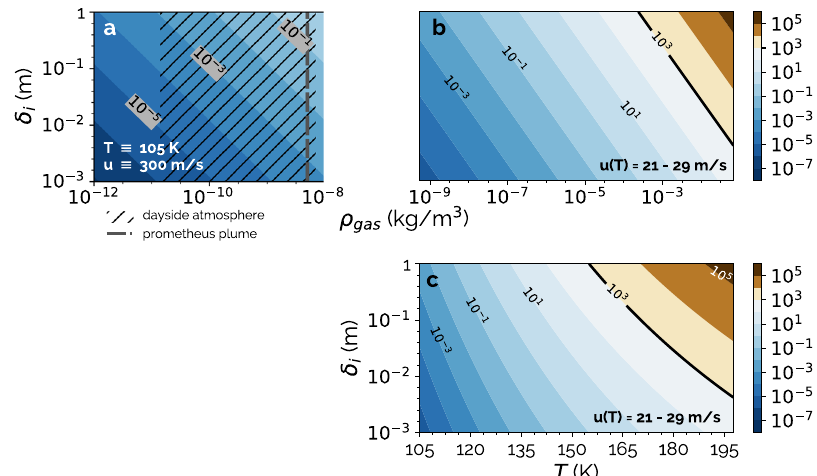
Fig. 1 Reynolds number (Re) contours. a For the atmospheric densities ( ρ gas ) representative of Io ’ s ambient atmosphere, with the hatching and the dashed line indicating parts of the parameter space occupied by speci fi c geographical regions. The fl oating powers of 10 are labels for the contours. The constant temperature ( T ) and wind velocity ( u ) used for this calculation are denoted. Calculations in a , b and c are a function of the atmospheric viscous sublayer height δ i which is not known for Io. b For the modeled sublimating vapor at the lava-SO 2 frost margins, as a function of the out fl owing vapor density ( ρ gas ). Note that in b , the calculated Re is a function of temperature, as the out fl owing vapor density is dependent on temperature. The outgassing velocity, u T , that Re is evaluated at in b and c is also a function of temperature. The contour for the critical Re value is denoted by the thick solid line. c , The same results shown in b , explicitly showing the dependence on SO 2 sublimation